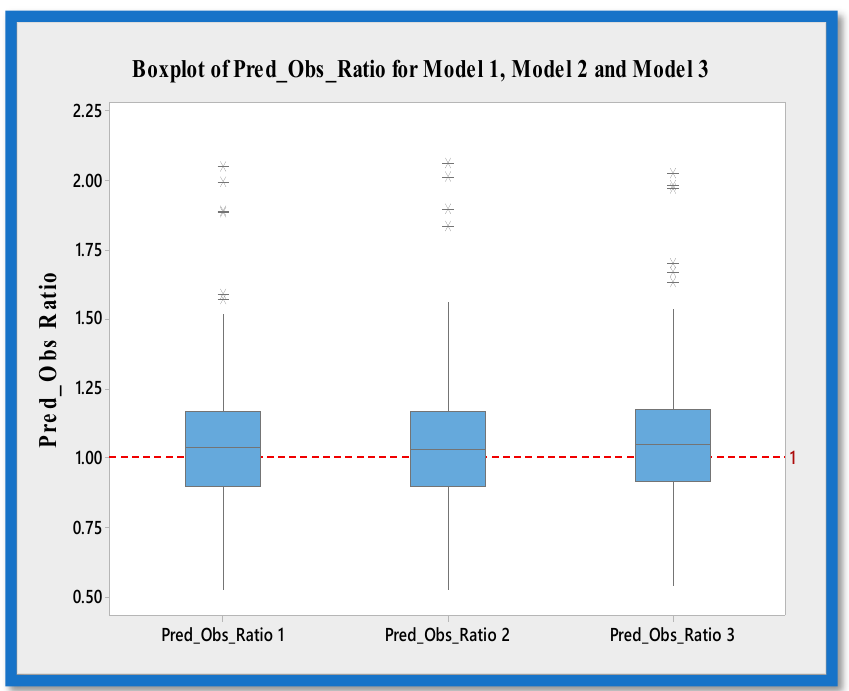
11 of 16 Figure 7. Relative error RE (%) of Models 1, 2, and 3 (mod-still). (* represents outlier data).